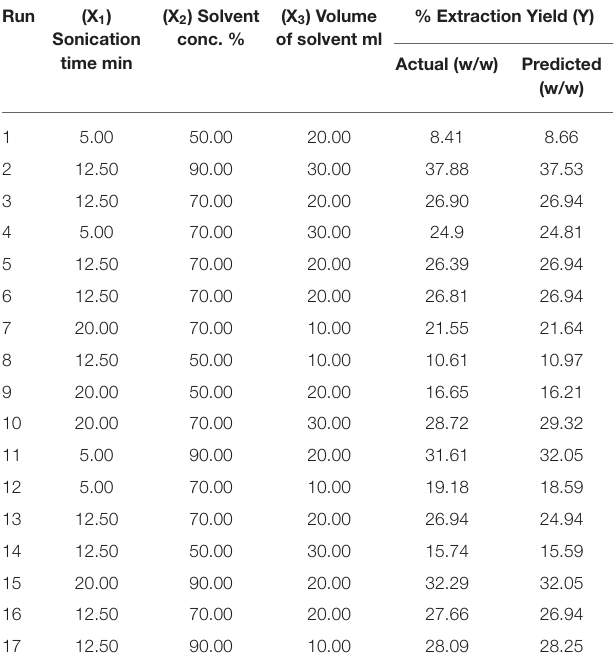
TABLE 2 | Actual and predicted EY at different extraction conditions in